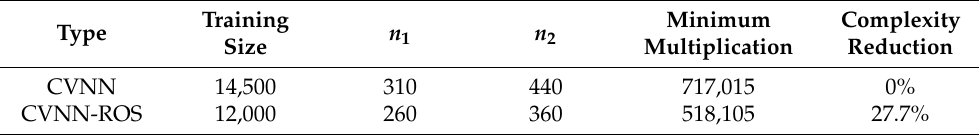
Table 1. Network parameters of various CVNN